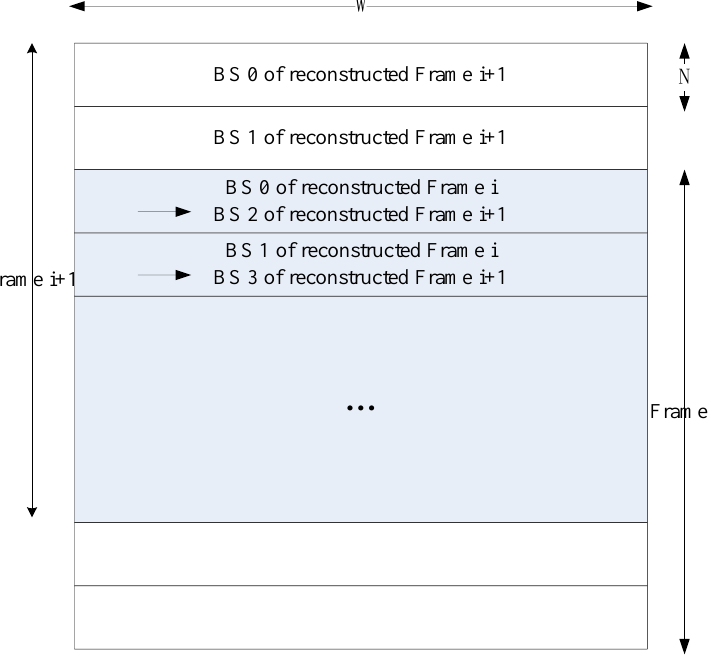
Figure 5. Architecture of Inter-E for VC-SRME. Circular frame buffer is used. The grey part is the shared buffer between Frame i and Frame i + 1.